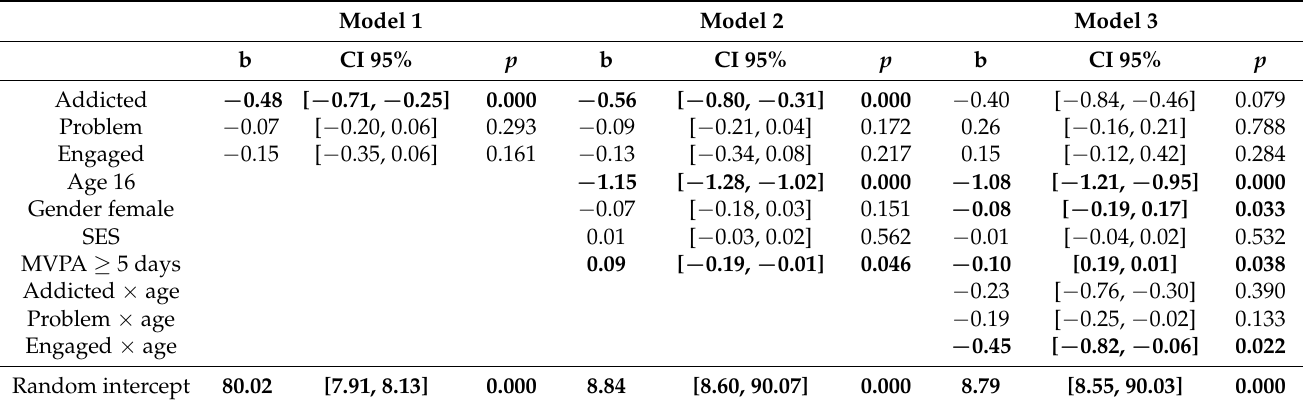
Table 2. Crude and adjusted associations of gaming behavior and sleep duration on weekdays. Model 1